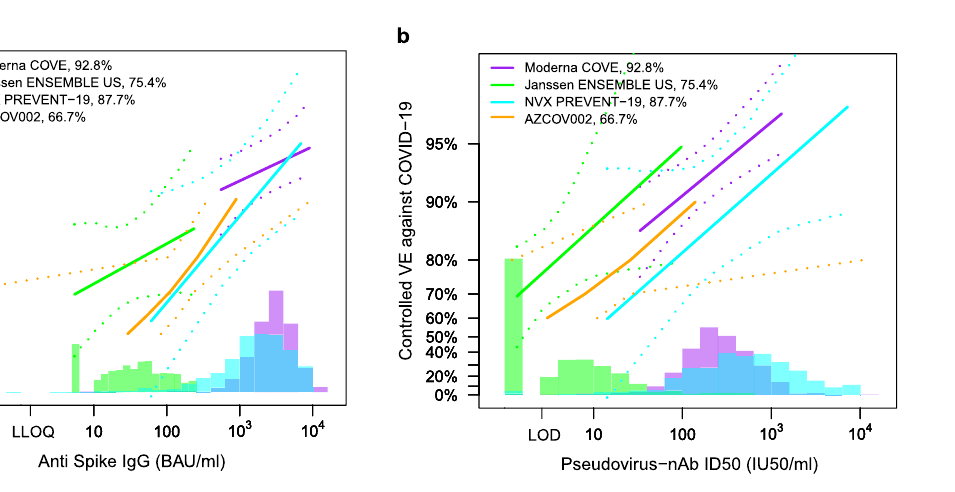
Fig. 6 | Vaccine ef fi cacy (solid lines) in baseline SARS-CoV-2 negative per- protocol participants by post-vaccination antibody marker level in four ran- domized, placebo-controlled COVID-19 vaccine ef fi cacy trials. Vaccine ef fi cacy (VE) was estimated using the marginalized Cox proportional hazards imple- mentation of ref. 45 . Vaccine ef fi cacy estimates are shown by a anti-spike IgG con- centration [D57 in COVE, D29 in ENSEMBLE-United States sites (ENSEMBLE-US), D35inPREVENT-19,D56inCOV002]orby b